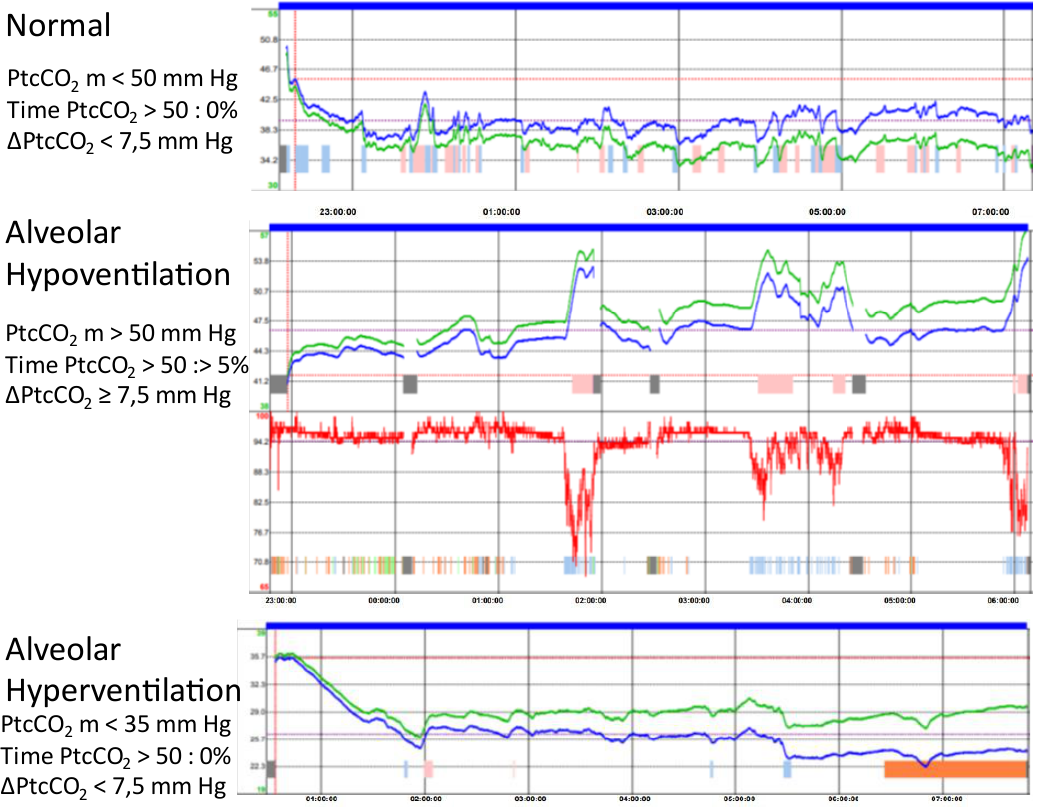
Figure 6. Transcutaneous capnography. Typical results in statistics and on visual inspection of the PtcCO 2 curve for different types of respiratory events. Δ PtcCO 2 : difference between the maximum and the baseline PtcCO 2 . Green line is raw measurement. Blue line is measurement corrected for